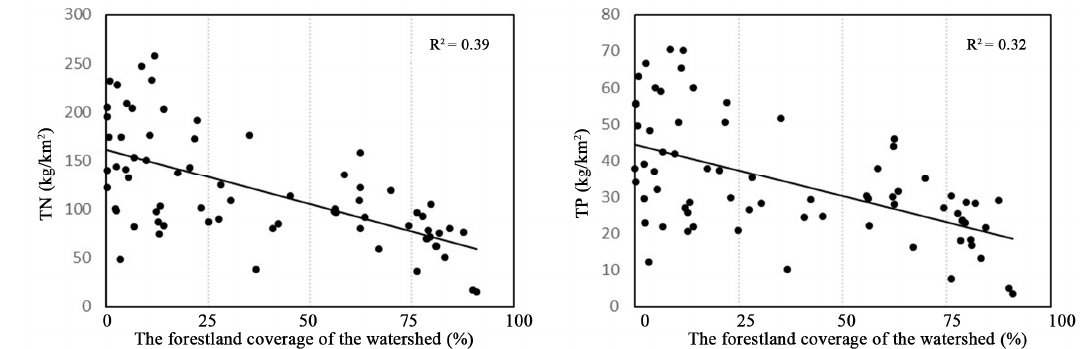
Figure 5. Monthly distribution characteristics of nutrients outputs with different FLTs: (a) was the distribution of TN; (B) was the distribution of TP.